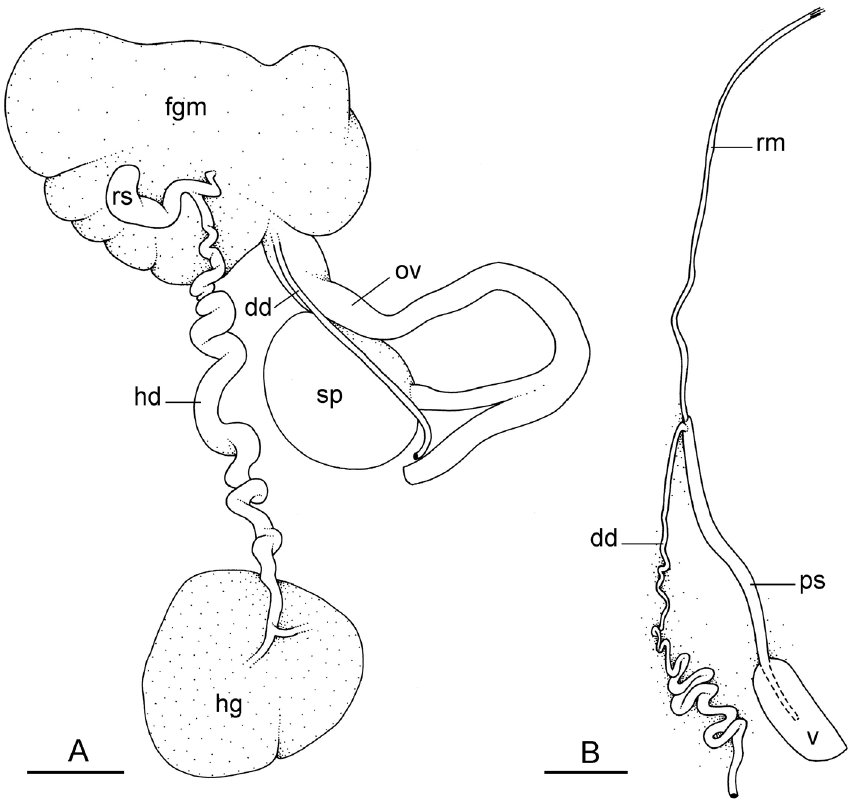
Figure 52. Reproductive system, Wallaconchis achleitneri , Australia, Queensland (MTQ st117). A Her- maphroditic (female), posterior parts, scale bar 1 mm [#4] B Anterior, male copulatory parts, scale bar 1 mm [#1]. Abbreviations: dd deferent duct fgm female gland mass hd hermaphroditic duct hg hermaph- roditic gland ov oviduct ps penial sheath rm retractor muscle rs receptaculum seminis sp spermatheca v vestibule.